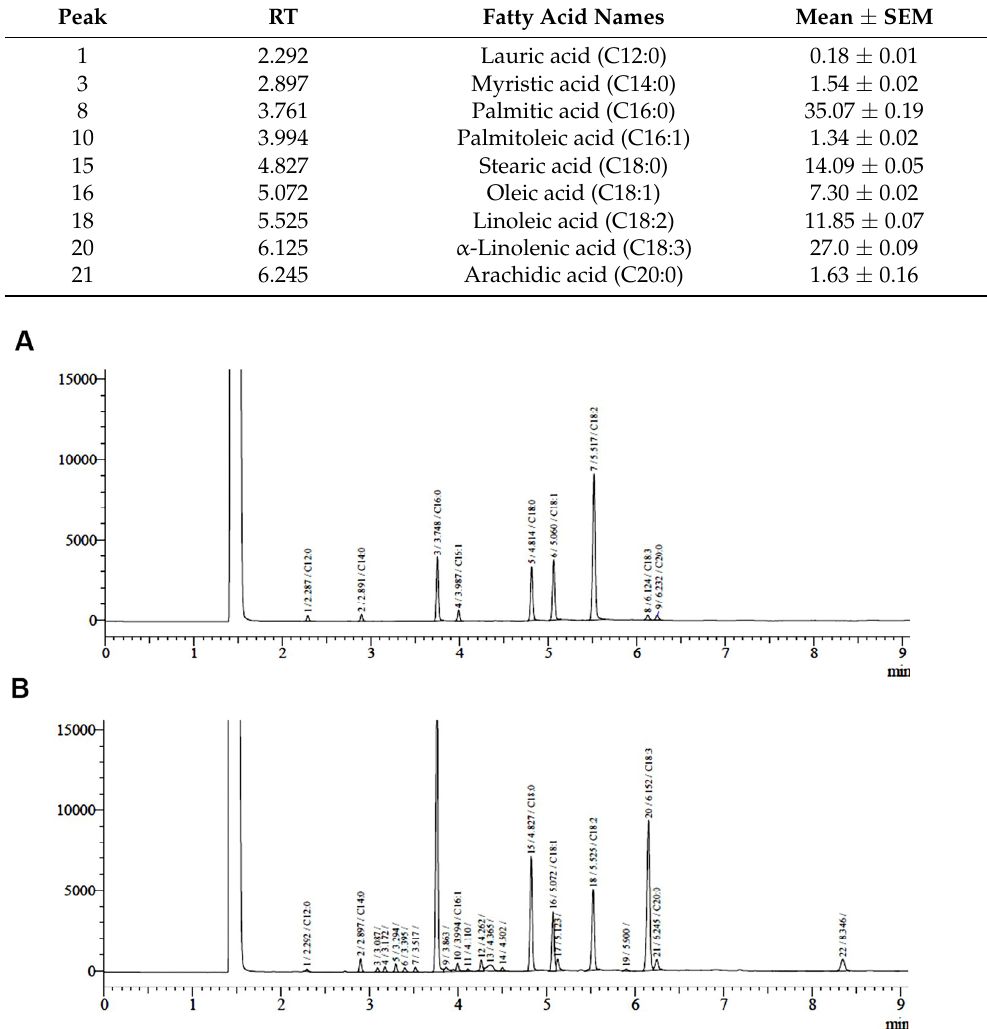
Figure 6. Chromatograms of the fatty acid content of the oil fraction obtained by the GC-FID analysis. ( A ) Standard chromatogram of 9 fatty acids that are known as lauric acid (C12:0), myristic acid